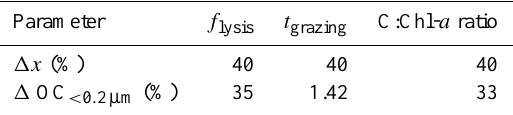
Table 6. Sensitivity of OC < 0 . 2 µ m concentrations estimated with Eq. (7) to 40% variations in f lysis , t grazing and C:Chl- a ratio ( x